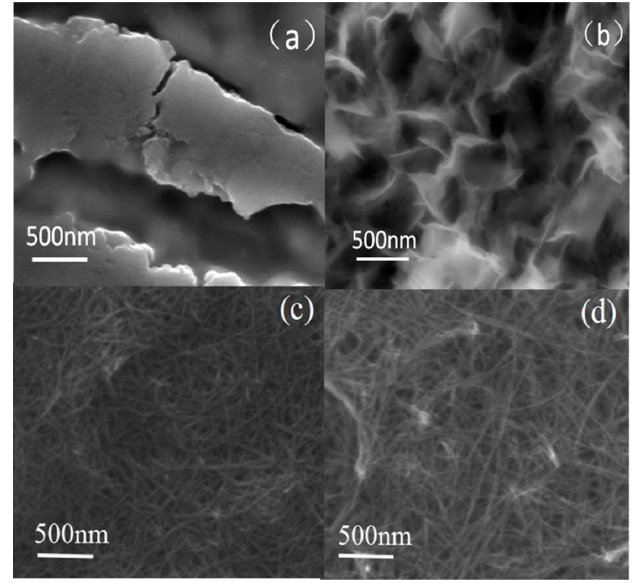
Figure 2. Scanning electron microscope (SEM) images of samples. ( a ) Ti foil; ( b ) intermediate on the Ti foil; ( c ) intermediate product after pickling is on the Ti foil; ( d ) TiO2 nanotubes network.